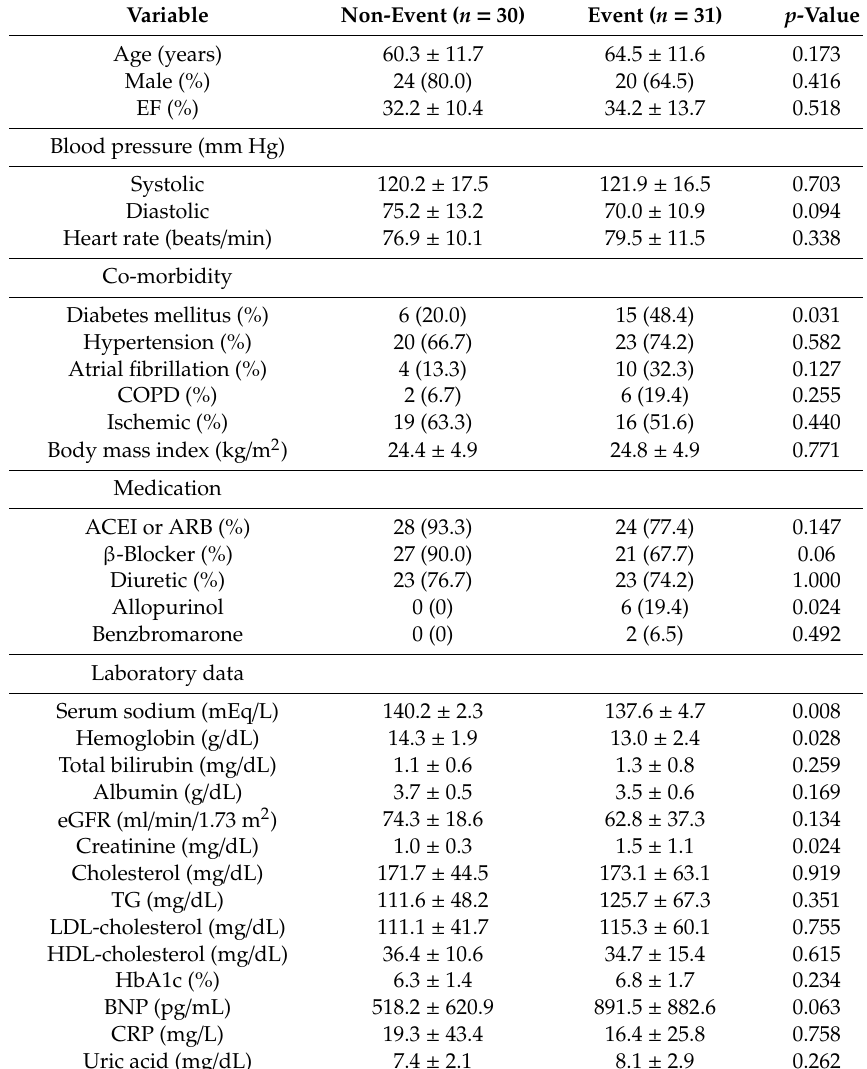
Table 1. Characteristics and laboratory data of 61 heart failure patients in event and non-event